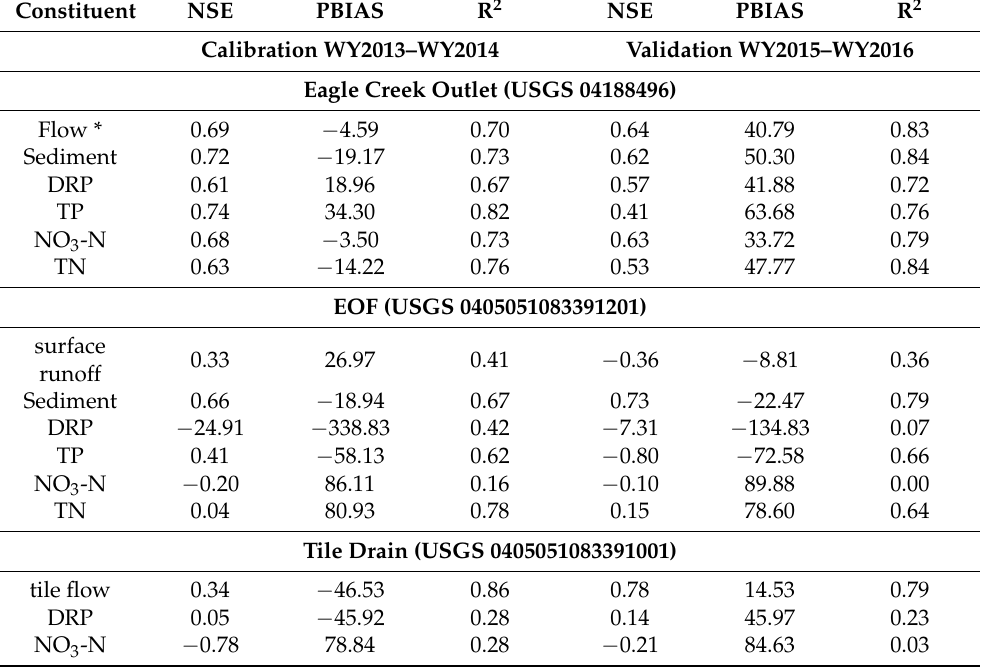
Table 6. Calibration and validation summary statistics at the monthly time step for Eagle Creek watershed, Ohio SWAT model.